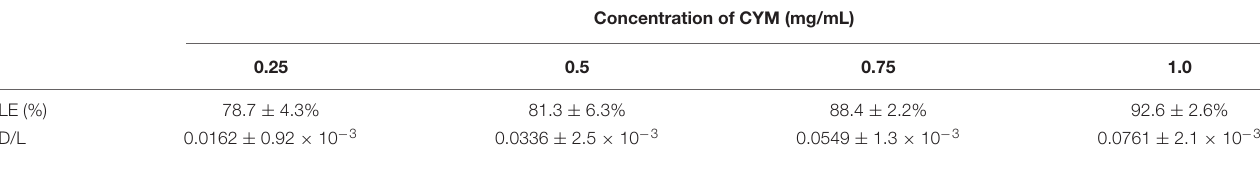
TABLE 2 | Loading parameters of CYM-loaded